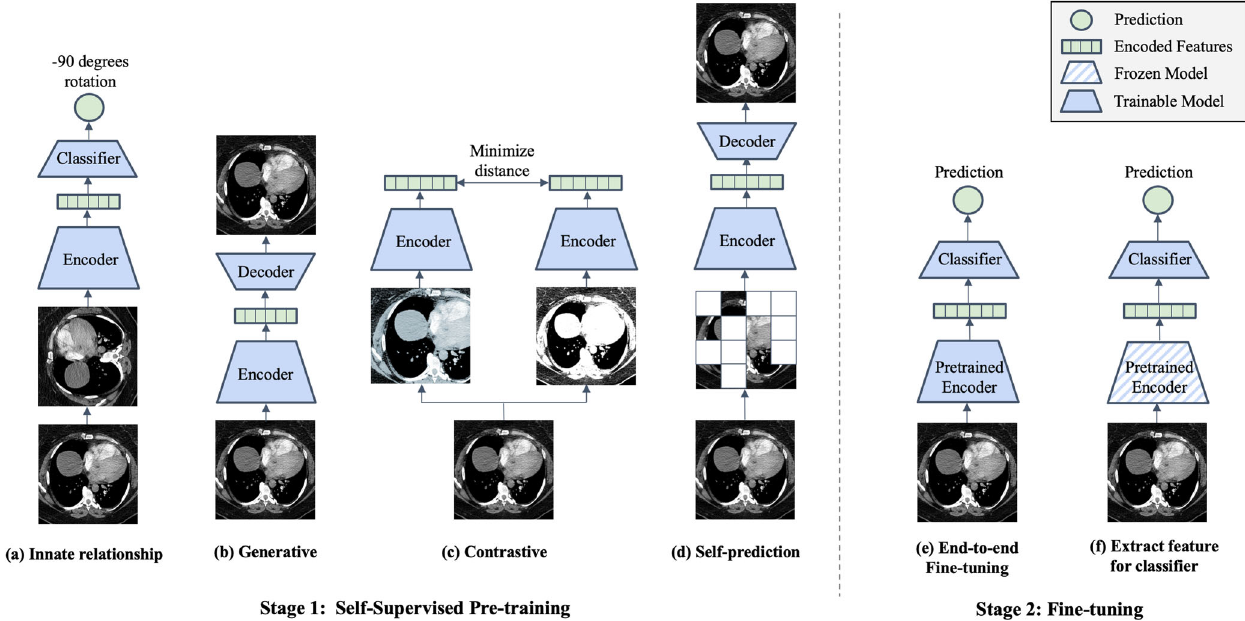
Fig. 2 Illustration of different self-supervised learning and fi ne-tuning strategies. During Stage 1 a model is pre-trained using one or more of the following self-supervised learning strategies: ( a ) Innate relationship SSL pre-trains a model on a hand-crafted task by leveraging the internal structure of the data, ( b ) Generative SSL learns the distribution of training data, enabling reconstruction of the original input ( c ) Contrastive SSL forms positive pairs between different augmentations of the same image and minimizes representational distances of positive samples ( d ) Self-prediction augments or masks out random portions of an image, and reconstructs the original image based on the unaltered parts of the original image. During Stage 2, the pre-trained model can be fi ne-tuned using one of the following strategies: ( e ) end-to-end fi ne- tuning of the pre-trained model and classi fi er, or ( f ) train a classi fi er that uses extracted features from the SSL pre-trained